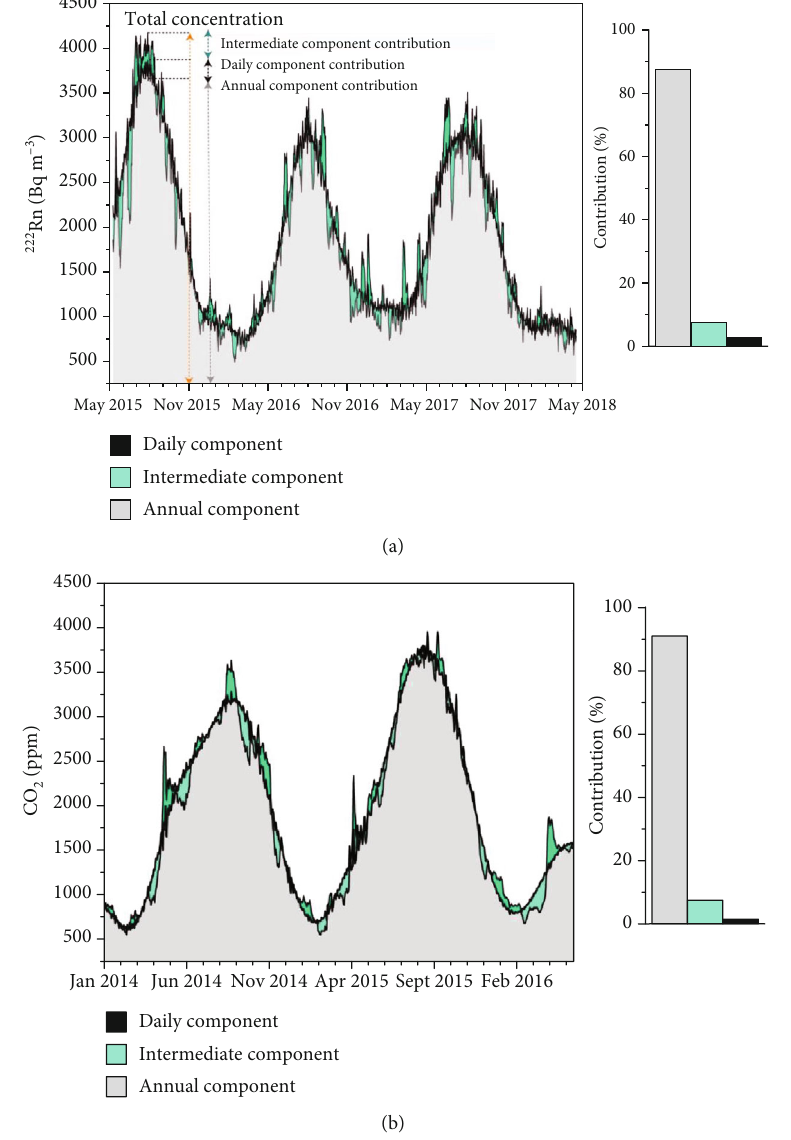
Figure 4: Contribution of the di ff erent frequency components (annual, intermediate, and daily) to the global gas 222 Rn (a) and CO concentrations. The sub fi gures are not coincident in the time domain because they represent the maximum available continuous measurement range with the absence of missing